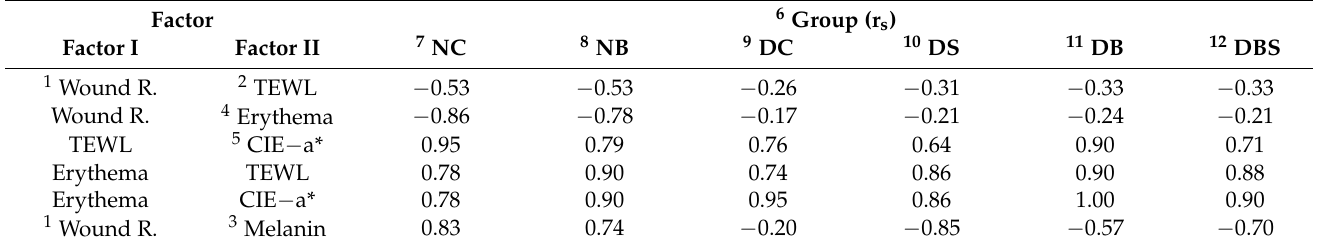
Table 1. Correlation values for wound recovery and skin surface characteristic